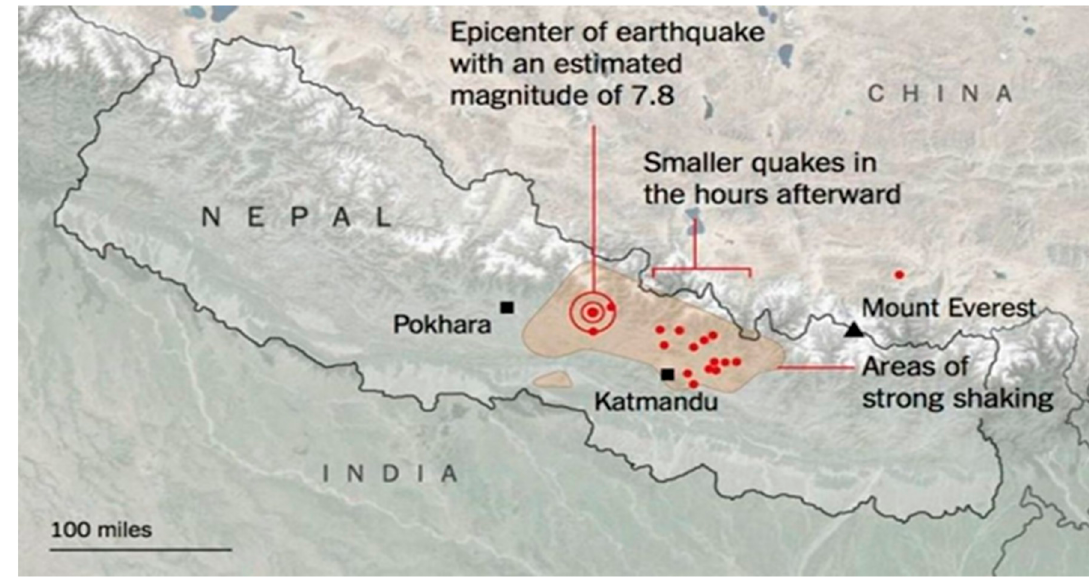
Figure 1. 2015 Earthquake epicenter [44].